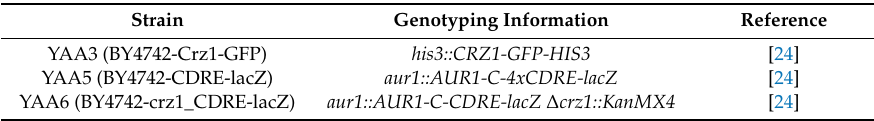
Table 1. List of S. cerevisiae strains used in this